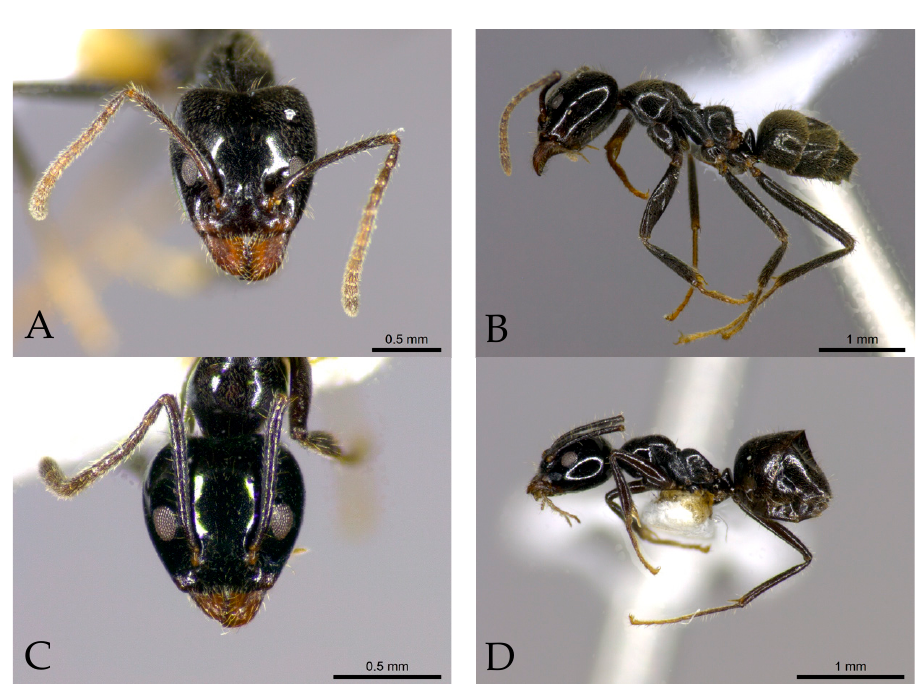
Figure 4. Head and lateral views of Anonychomyrma sp. C ( A , B ) and Anonychomyrma malandana ( C , D ).